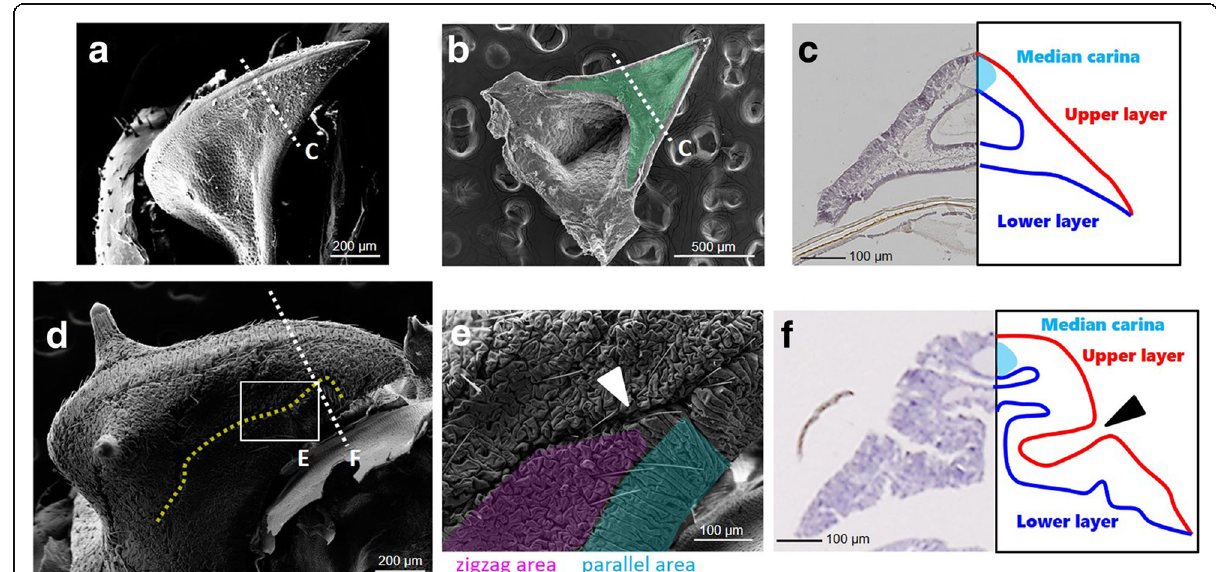
Fig. 6 Observation of developing helmet via SEM and paraffin section. a Whole morphology of developing miniature helmet by scanning electronic microscope (SEM) after removing outer nymphal cuticles. b Ventral view of miniature helmet by SEM. Septum is highlighted in green. c Paraffin section of miniature helmet. Upper (red line) and lower (blue line) layers can be recognized. Also, the median carina has already formed at top of the helmet, indicated as light blue. d Whole morphology of fully developed helmet by SEM after removing outer nymphal cuticles. e Magnified view of surface of the helmet. There are dense micro furrows and deep macro furrow (white arrowhead). Some areas have zigzag micro furrows (highlighted in pink) and some have parallel regular furrows (highlighted in blue). The micro furrows determine the rate and direction of expansion when extended. f Paraffin section of fully developed folded helmet. A deep macro furrow was made by bending the bi- layer cell sheet (black